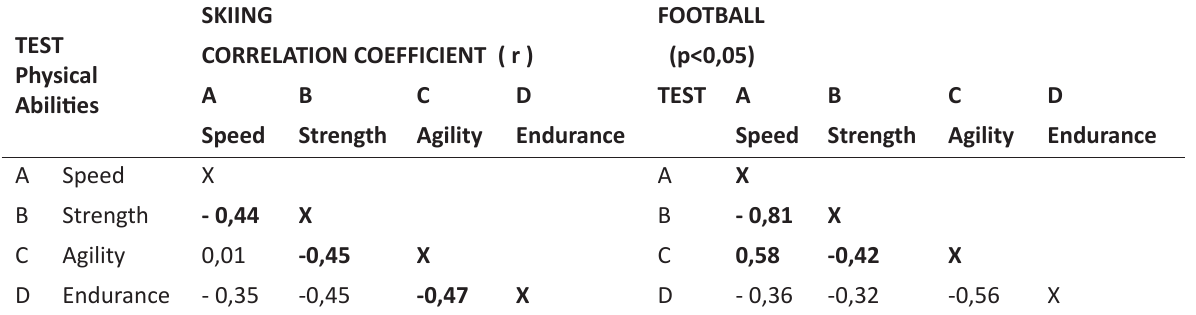
Table 5. Correlation coefficient between the tests in the selection ski and football